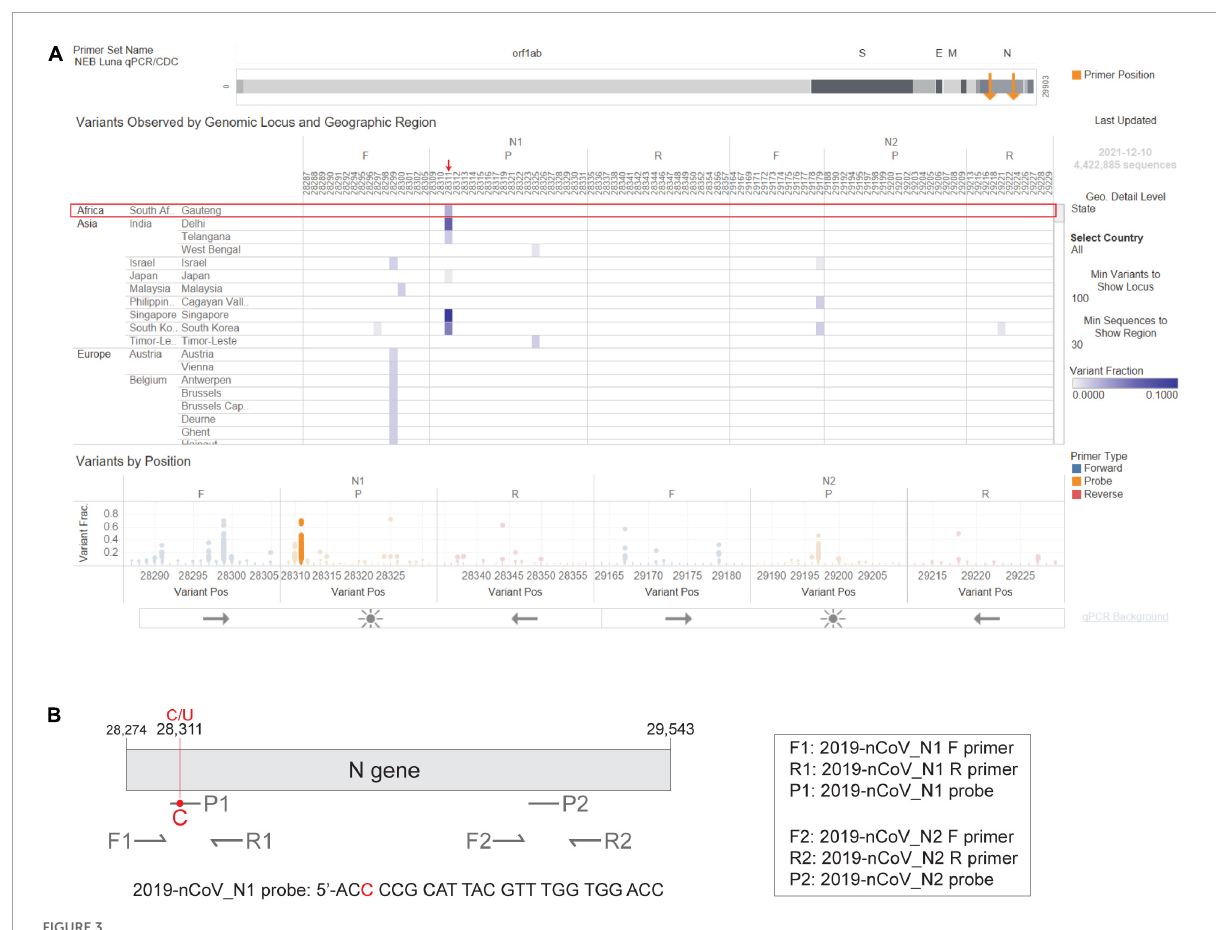
FIGURE3 The Omicron N gene contains a mutation targeted by the 2019-nCoV_N1 detection probe. The CDC 2019-Novel Coronavirus (2019-nCoV) Real-Time RT-PCR Diagnostic Panel includes two primer-probe sets that target the SARS-CoV-2 N gene, named 2019-nCoV_N1 and 2019-nCoV_N2. (A) Visual depiction of Omicron variant mutation within the N1 probe site generated using the Primer Monitor online tool (Tableau worksheet exported from Primer Monitor tool, primer set name “NEB Luna qPCR/CDC”). The Omicron variant from Gauteng, South Africa and the mutation are annotated with a red box and an arrow, respectively. (B) Schematic representation of the two CDC primer-probe sets. Each set includes one forward primer (F), one reverse primer (R), and one fluorescent probe (P). The SARS-CoV-2 Omicron variant has a C to U mutation at position 28,311, which is within the 2019-nCoV_N1 probe (P1) target sequence. Not drawn to